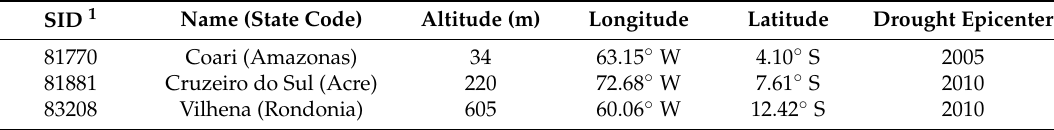
Table 1. Station description and